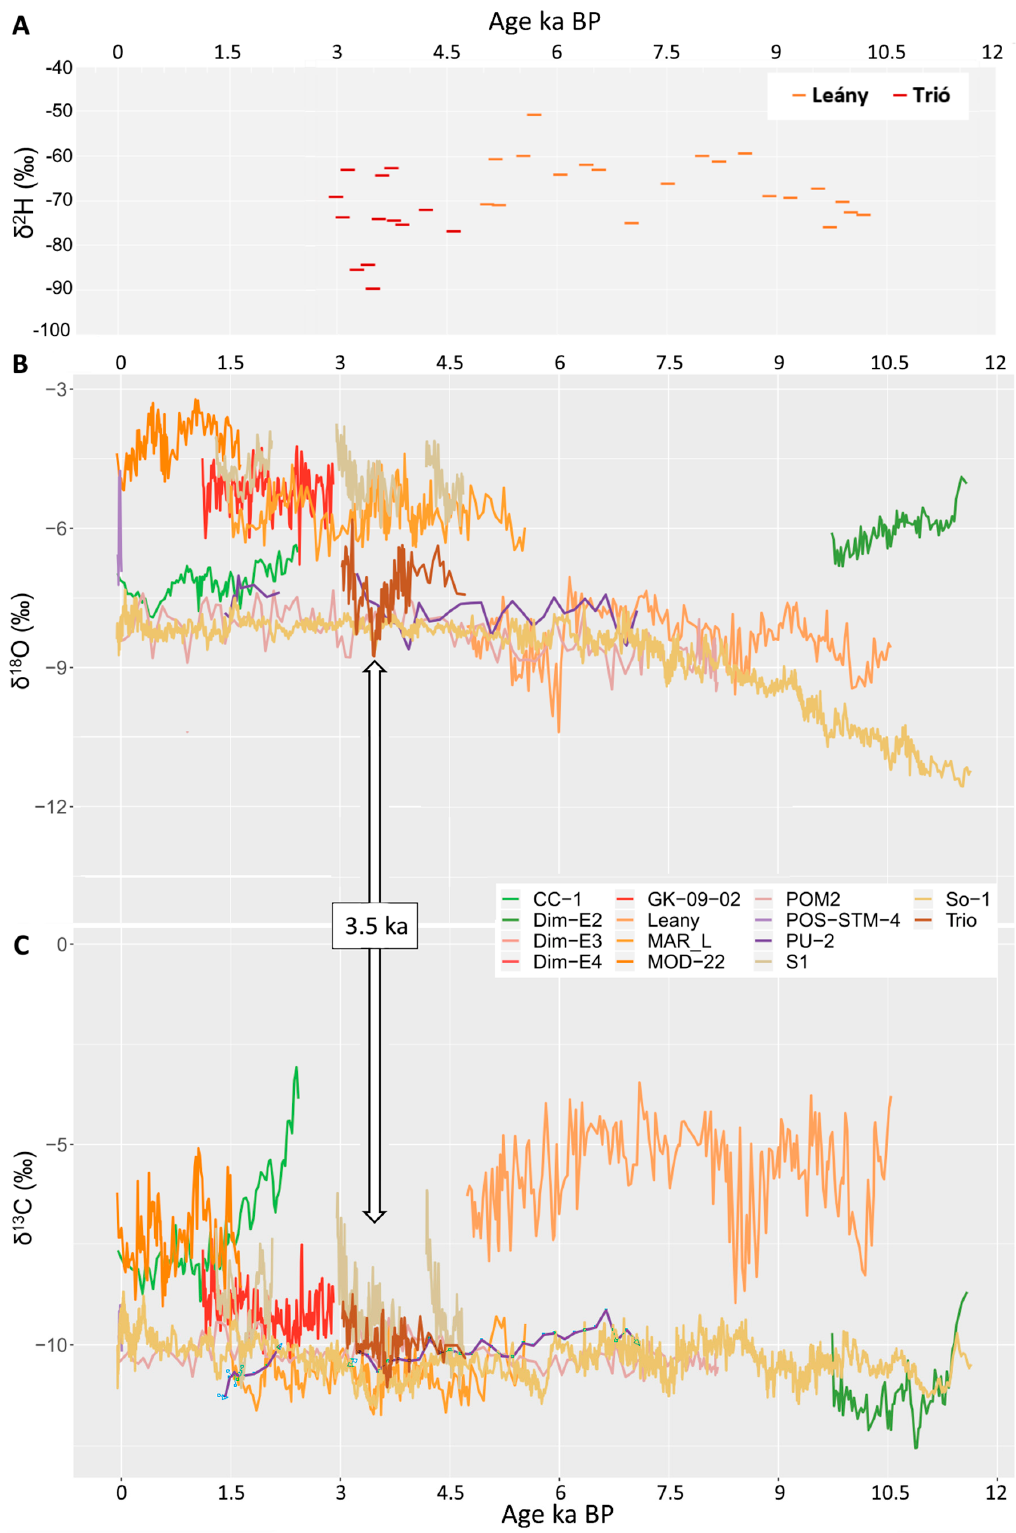
Figure 3. Stable isotope records of individual speleothems in the Eastern part of Europe and Turkey SISAL region for the Holocene: ( A ) Fluid inclusion δ 2 H, ( B ) δ 18 O spel and ( C ) δ 13 C. The vertical arrow marks 3.5 ka BP.